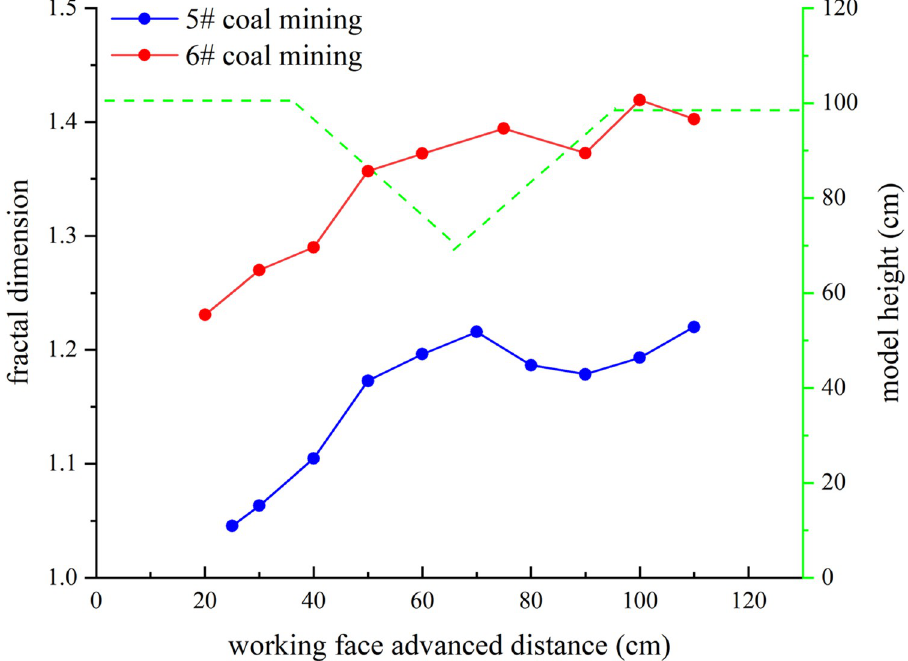
Fig 5. Line chart of fractal dimension of overburden